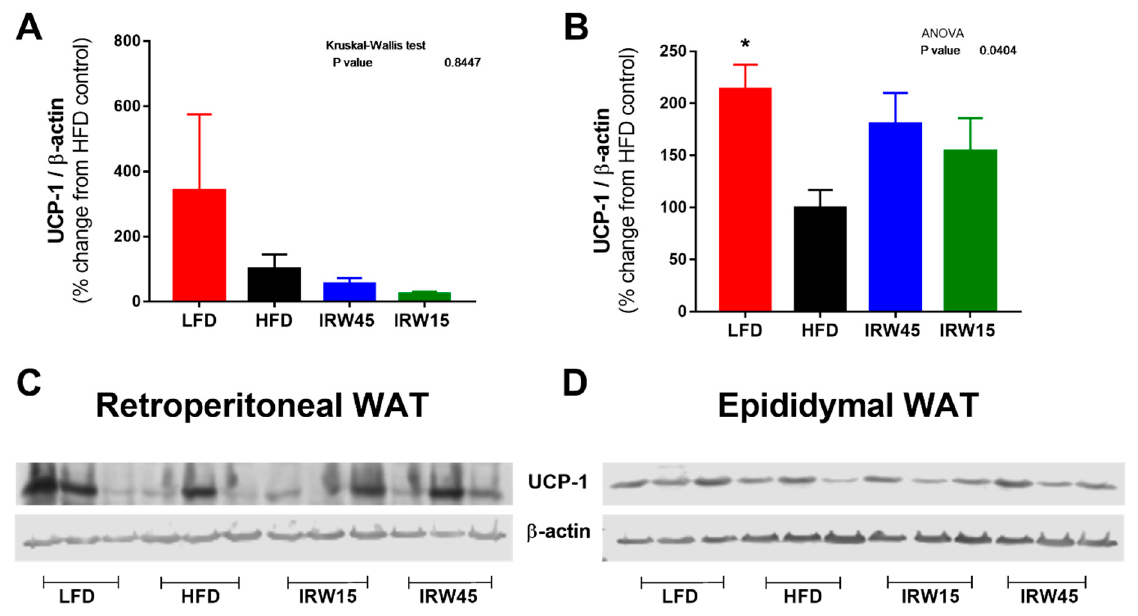
Figure 7. White adipose tissue UCP-1 protein abundance. Retroperitoneal WAT UCP-1 ( A ) and representative blot ( C ). Epidydimal WAT UCP-1 ( B ) and representative blot ( D ). UCP-1 was normalized to β -actin. Data expressed as mean ± SEM of n = 5–6 mice. Analysis by one-way ANOVA followed by Bonferroni’s post-hoc test or Kruskal–Wallis followed by Dunn’s post hoc test when appropriate. * p < 0.05 versus HFD. UCP, uncoupling protein.